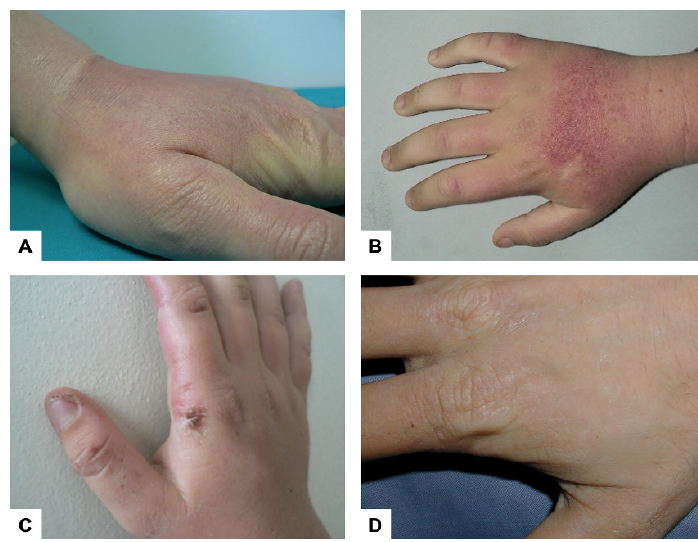
Figure 2. Cutaneous manifestations. ( A ) Edema. ( B ) Erythema. ( C ) Vesicles and bullous lesions. ( D ) Scarring of sun exposed areas.